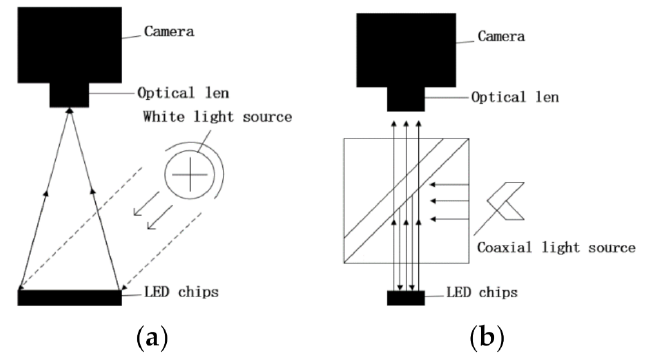
Figure 2. Schematic diagram of image acquisition system: ( a ) color image acquisition system; ( b ) coaxial image acquisition